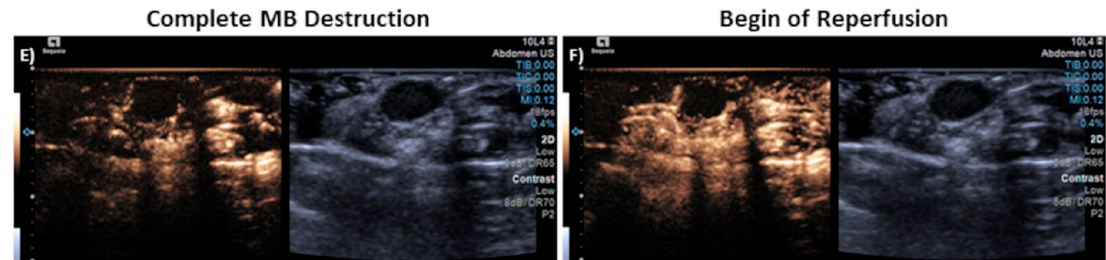
Figure 7. Representative ultrasound images in aythmic nude mice taken in dual B-mode/cadence pulse sequencing mode (Right/Left), imaging subcutaneous CAL27 human squamous cell carcinoma. ( A ) Pre tail vein injection of microbubbles (MB), area of tumor outlined, ( B ) Peak enhancement post injection, ( C ) Start of MB destruction, ( D ) Complete MB destruction, ( E ) Start of reperfusion, ( F ) Complete reperfusion. Note: The reverberation artifact on the right side of some images results from the clinical transducer imaging air as a consequence of being considerably wider than the mouse torso .